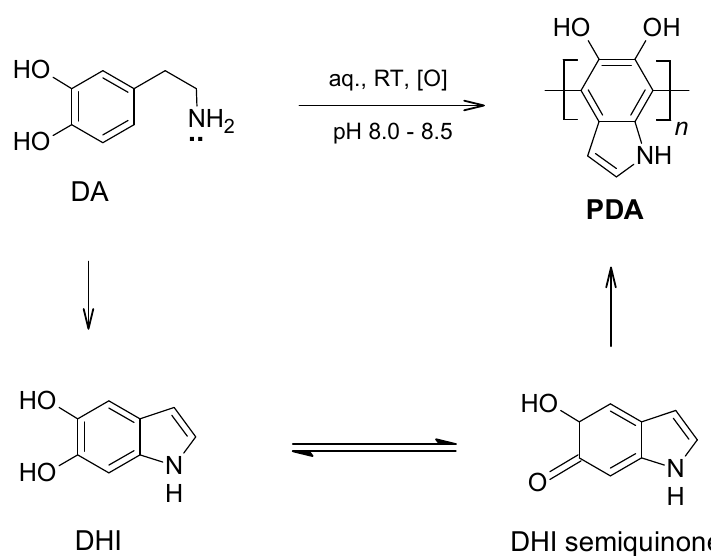
Scheme 13. Generic scheme for polydopamine (PDA) formation via a reactive 5,6-dihydroxyindole (DHI)